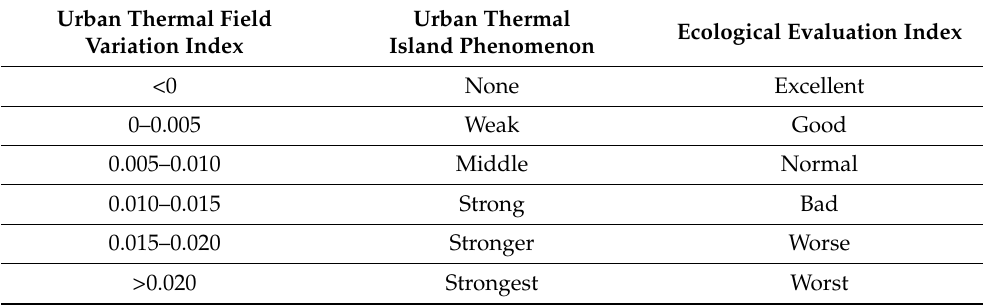
Table 3. Scale of Urban Thermal Field Variation Index